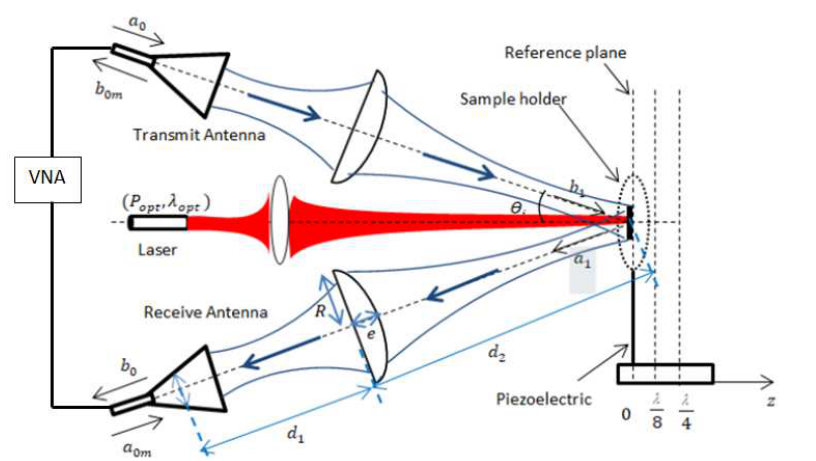
Figure 2. Schematic description of the experimental